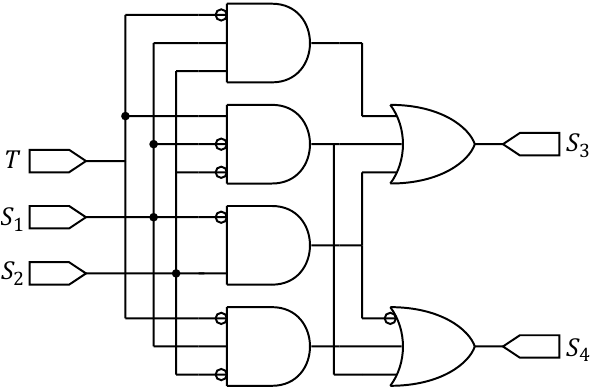
Figure 4. Combinatorial logic circuit for the proposed